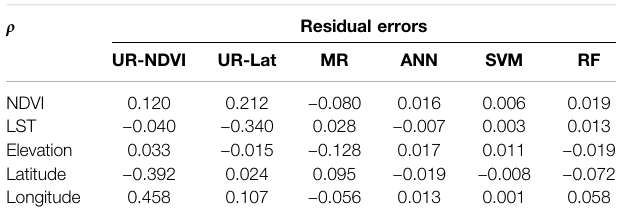
TABLE 4 | Statistical results of Spearman correlation coef fi cient ( ρ ) between auxiliary variables and residual errors of different downscaling methods in